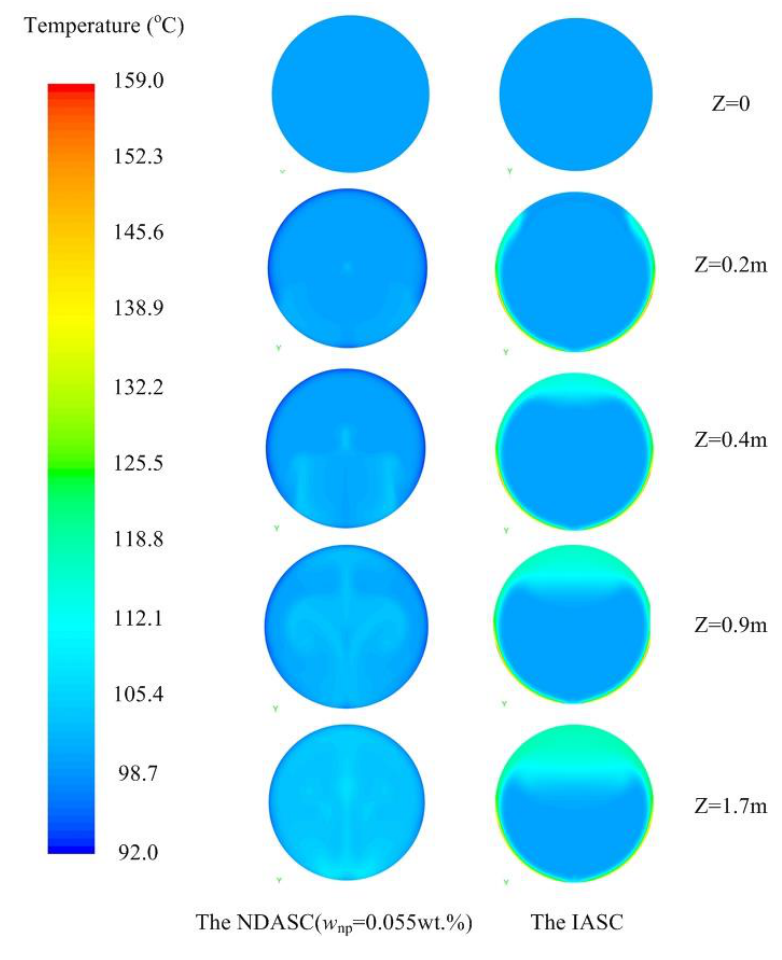
Figure 7. Fluid’s temperature distributions of cross sections at different length points ( t f,i = 100 °C).